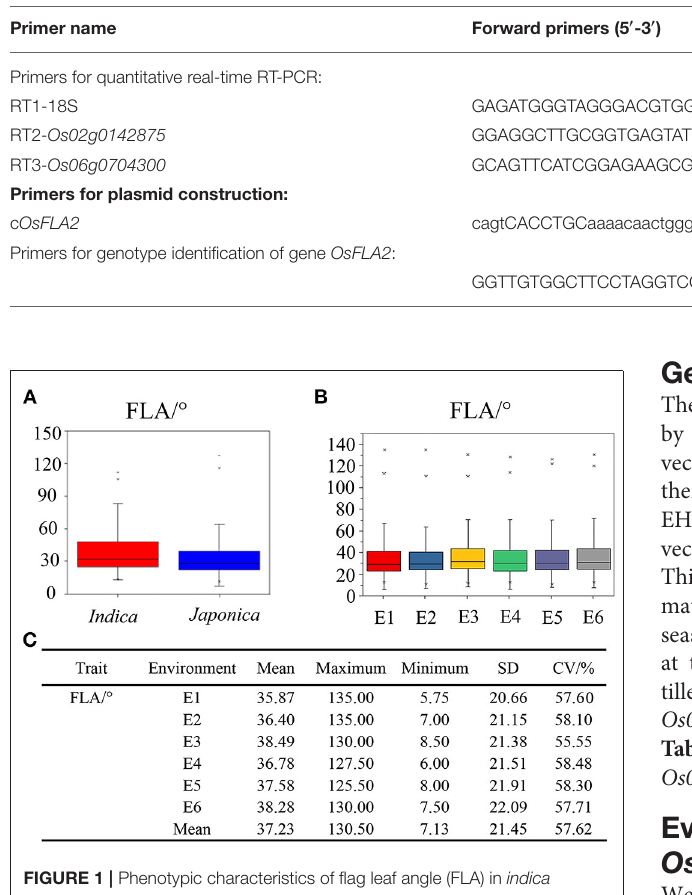
TABLE 1 | Primers used in this study.